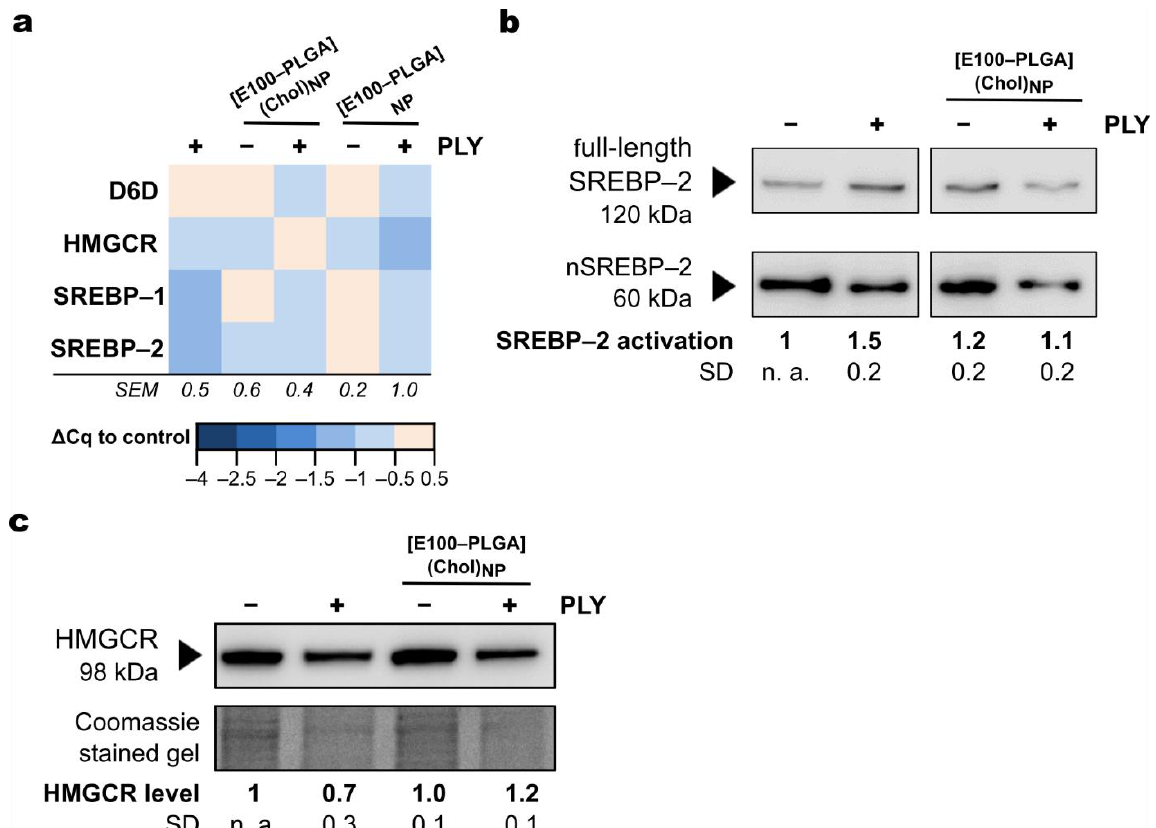
Figure 3. Intracellular delivery of cholesterol stabilizes critical components of the cholesterol biosynthesis pathway during PLY stress. ( a ) The cellular response to PLY (250 ng mL −1 ) was analyzed on a transcriptional level by semi-quantitative PCR in the presence of [E100 – PLGA]-nanoparticles (50 µg mL −1 ). The level of transcriptional regulation was calculated from at least three replicated experiments and is shown color-coded compared to the expression of untreated control cells. SEM represents the mean inter-assay standard error of the genes listed under the indicated treatment. ( b , c ) Key regulators of cholesterol biosynthesis were immunoblotted after 3 h of treatment with PLY, cholesterol [E100 – PLGA](Chol) NP, or a combination thereof from at least three independently extracted protein lysates. One representative Western blot is shown. Blot images are cropped, and contrast has been adjusted for better visualization. An unedited full-size visualization of all replicas is provided with the Supplementary Information. ( b ) Activation ratio of SREBP – 2 was calculated and is given in relation to the untreated control: SREBP – 2 activation = nSREBP – 2/(nSREBP – 2 + full-length SREBP – 2). ( c ) The level of detected HMGCR protein is shown relative to untreated control after correction of Western blot signal intensities by Coomassie gel staining.